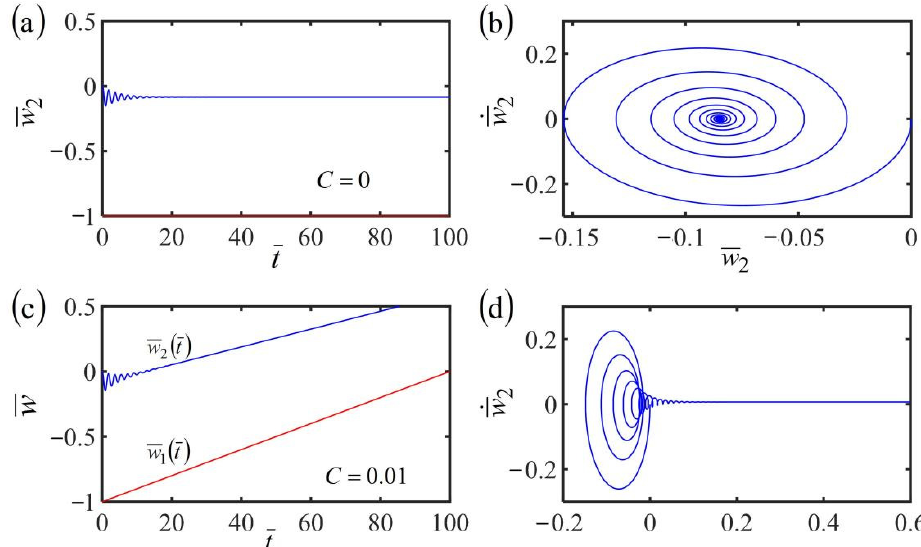
Figure 4. ( a ) Time history and ( b ) phase trajectory of the displacement of the system consisting of fiber and mass in the case of the frame at rest in a linear temperature field. ( c ) Time history and ( d ) phase trajectory of the displacement of the system consisting of fiber and mass in the case of the frame at uniform translation in a linear steady temperature field. The red line represents w 1 ( ) (cid:0) (cid:1) t and the blue line represents w 2 . The equilibrium position of mass and the length of the LCE fiber depend on the translation of the frame.